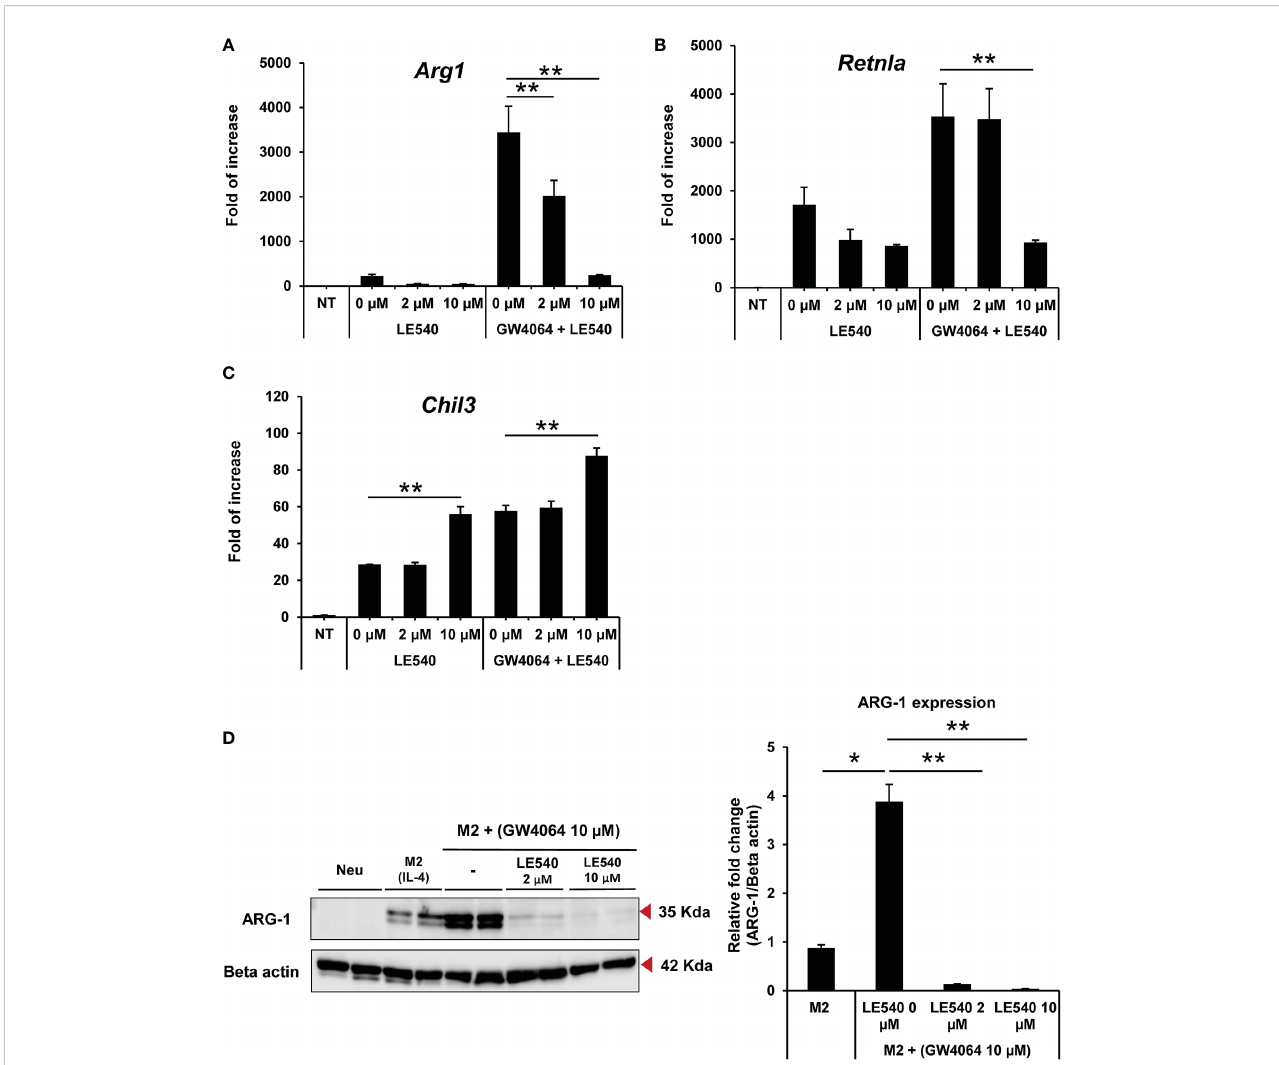
FIGURE 4 Inhibition of the retinoic acid receptor by LE540 reduced expression of M2-related markers induced by GW4064-mediated FXR activation. BMDMs were treated with 2 and 10 m M of LE540 with or without 10 m M of GW4064 under M2 conditions for 1 d. Messenger RNA gene expression of Arg1 (A) , Retnla (B) and Chil3 (C) was evaluated by RT-qPCR. (D) Immunoblotting analysis of ARG-1 (35 kDa) expression in BMDMs treated with 2 and 10 m M of LE540 with or without 10 m M of GW4064 under M2 conditions for 2 d and left untreated as a Neu condition (left panel). The expression level of ARG-1 was normalized to b -actin (42 kDa) expression, with the graph showing the relative expression of ARG-1 in BMDMs treated with or without LE540 in the presence of GW4064 compared to that observed with the control M2 condition (right panel). Each experiment was performed in triplicate and repeated three times. The results of the representative data are shown as mean +/- SD. Analysis of variance (ANOVA) was used for the statistical analysis. *P < 0.05, **P <